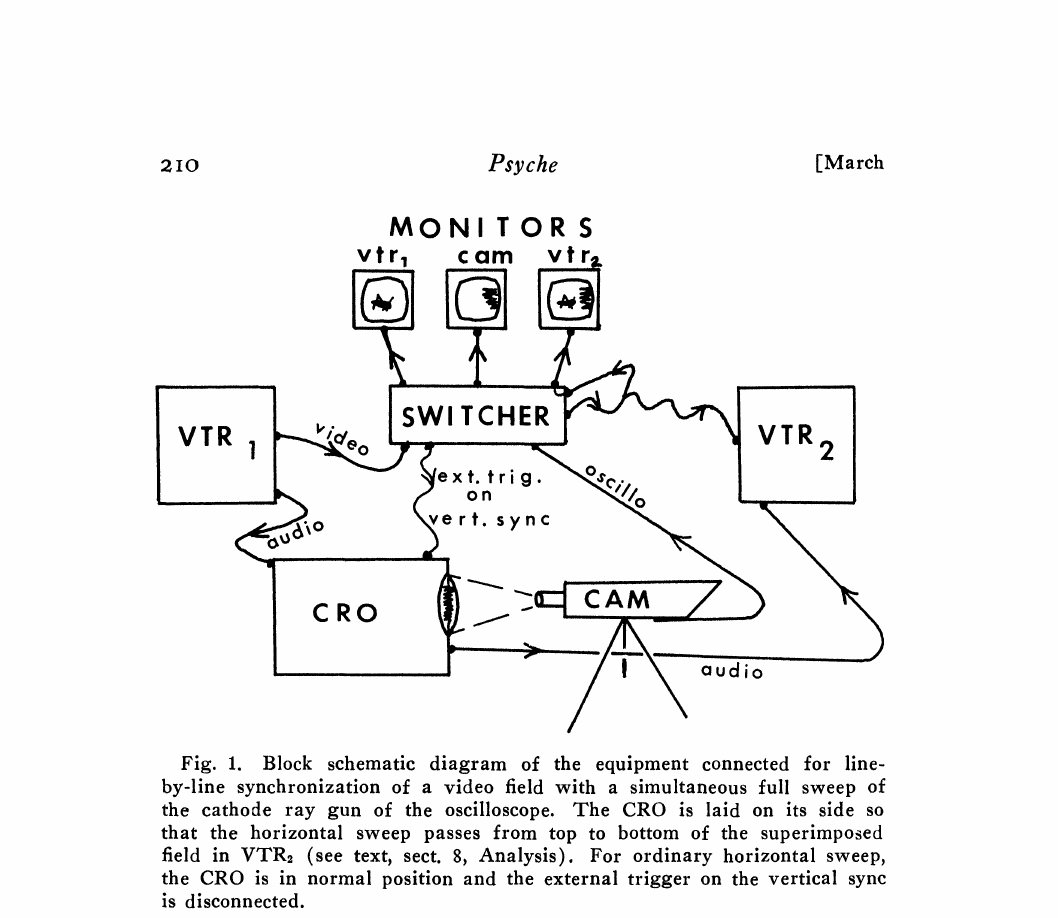
Fig. 1. Block schematic diagram of the equipment connected for line- by-line synchronization of a video field with a simultaneous full sweep of the cathode ray gun of the oscilloscope. The CRO is laid on its side so that the horizontal sweep passes from top to bottom of the superimposed field in VTR2 (see text, sect. 8, Analysis). For ordinary horizontal sweep, the CRO is in normal position and the external trigger on the vertical sync is